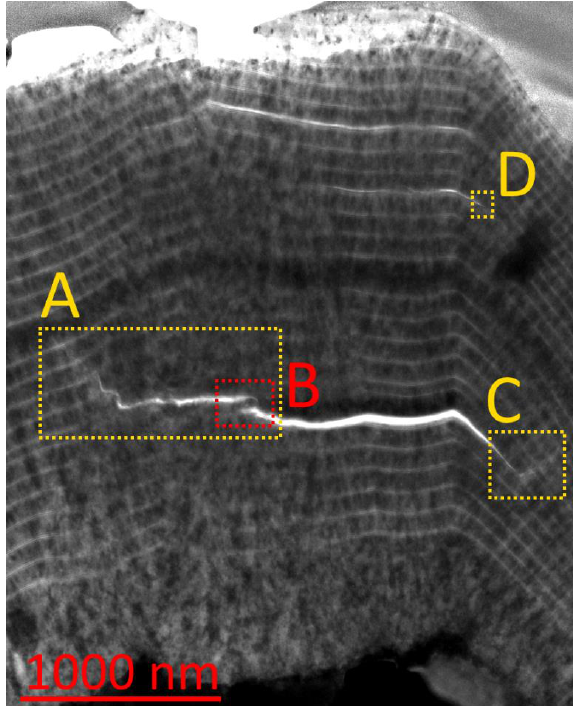
Figure 6. Formation of cracks and delaminations in the structure of the Zr,Nb-(Zr,Nb)N- (Zr,Nb,Al)N coating under the influence of the cutting conditions. coating under the influence of the cutting